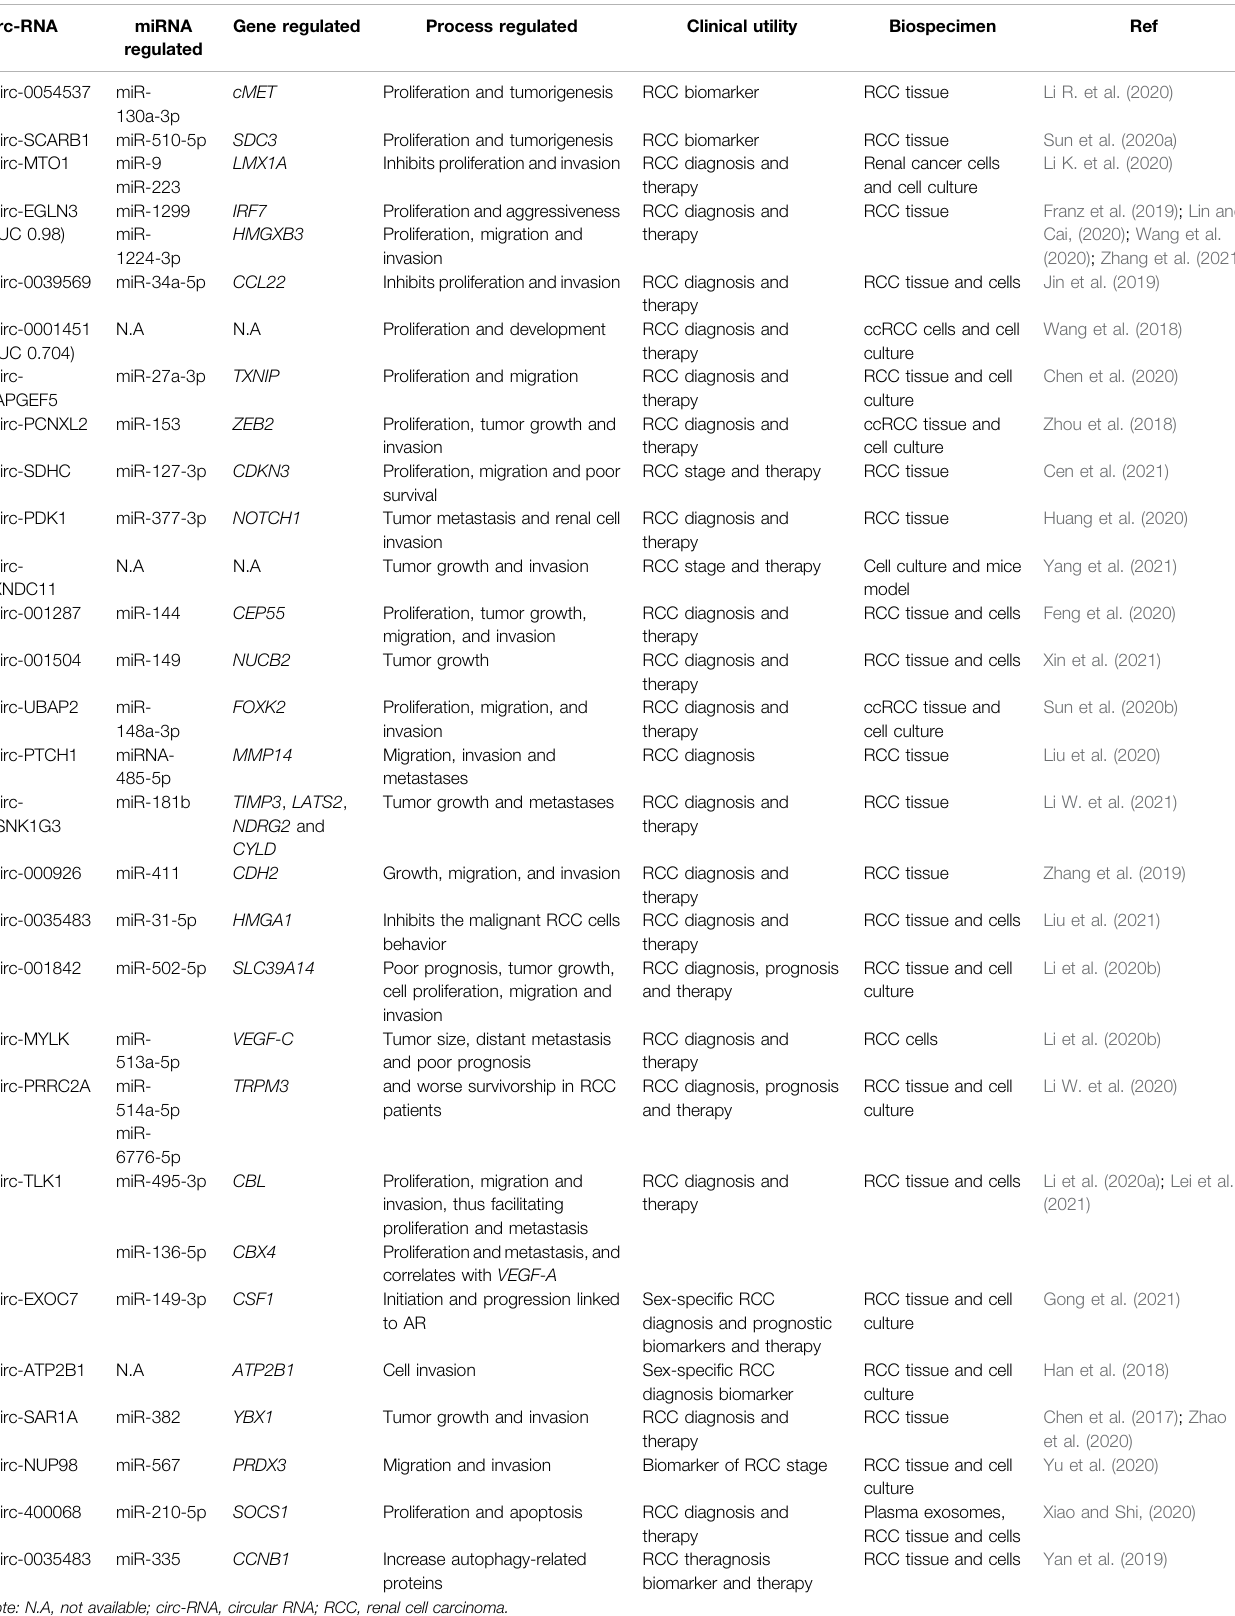
TABLE 1 | circRNAs described in different processes related to cancer development.